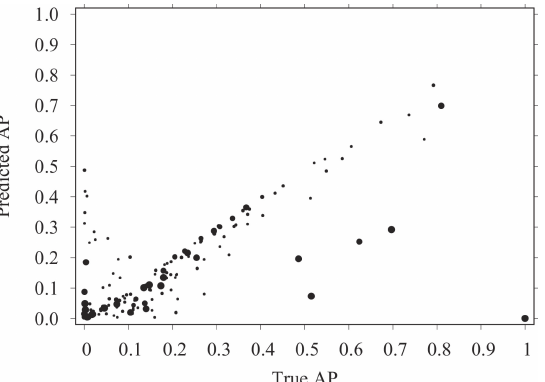
Figure 15. Predicted AP is correlated to actual AP for easy queries (the ones on the right part of the plot), although there are sparse. Figure reprinted with permission from Roy et al. [78], Copyright 2019,